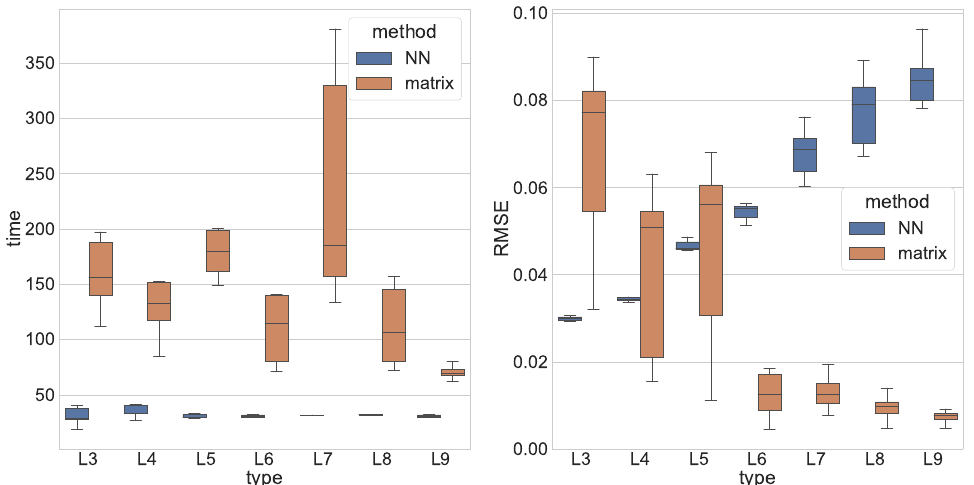
Figure 5. Legendre polynomial solution time ( left ) and solution error ( right ). The order of the polynomial n in Equation (12) is indicated by the type of curve, while different colors represent different approximations, i.e., neural network-based and matrix-based.